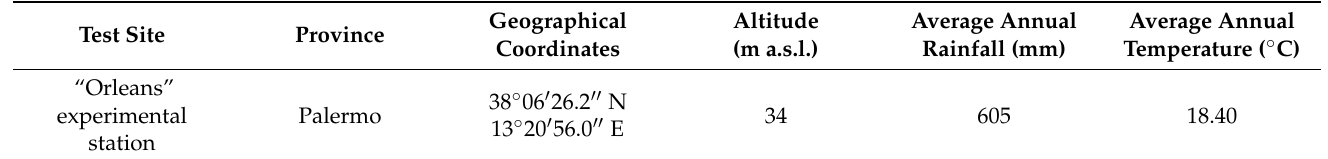
Table 1. Test site information.